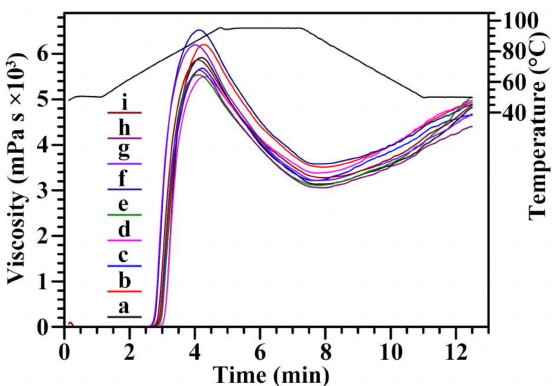
Figure 7. RVA profiles of starches from variety 3113 ( a ), Benlizi ( b ), Dahongpao ( c ), Erqingzao ( d ), Heishanzhai 7 ( e ), Mi 5 ( f ), Mi 6 ( g ), Yangguang ( h ), and Yanshanhong ( i